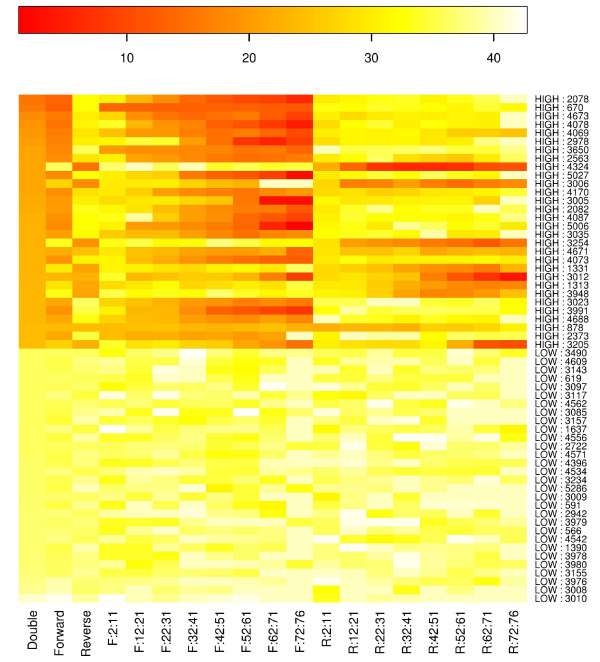
Sequencing error rate for different parts of the read. Along the y-axis, the first 30 positions have the highest error rate on the PhiX174 genome, and the last 30 positions have the lowest error rate. The x-axis indicates the strand (F, forward; R, reverse) and read bins (positions 2 to 11, 12 to 21, 22 to 31, 32 to 41, 42 to 51, 52 to 61, 62 to 71, and 72 to 76).